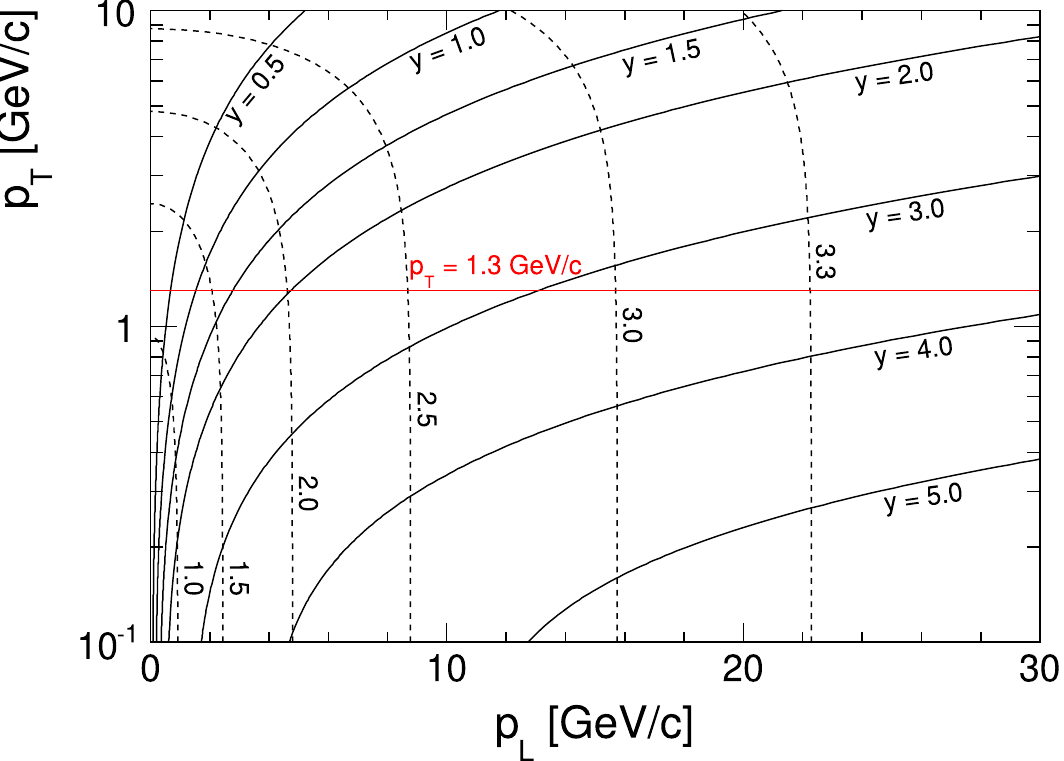
Fig. 137 Kinematical relation between the orthogonal longitudinal and transverse momentum variables p L and p T and lines of constant rapidity (full lines). For different interaction energies log ( s ) the kinematic limits are indicated (dashed